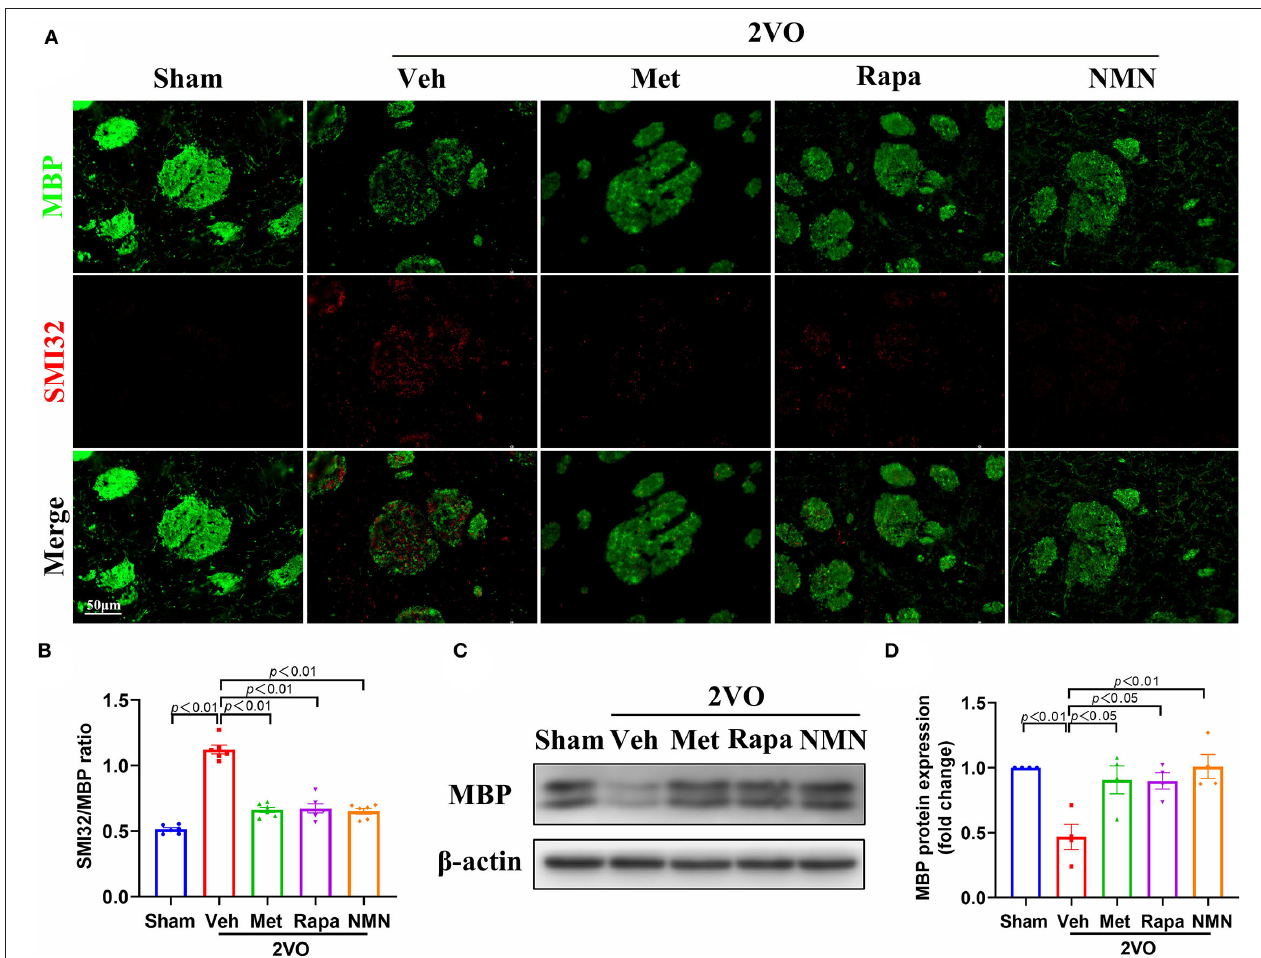
FIGURE 3 | Metformin, rapamycin, or NMN pretreatment improves axonal and oligodendrocyte damage induced after BCCAO. (A) Representative images of dephosphorylated neurofilament protein (SMI32, red) and MBP (green) in striatum 32 days after BCCAO in rats. (B) Quantification of the ratio of SMI32 to MBP fluorescence intensity in the striatum, illustrated as fold-change compared with the sham average value. n = 6 per group. The p -values were assessed by one-way ANOVA with a Tukey’s test. (C) Western blot analysis of MBP protein from the striatum in sham and BCCAO rats after treatment. (D) Quantitative analysis of MBP protein from the striatum in each group. MBP protein was normalized to the β -actin level of the same sample ( n = 4 per group). The p -values were assessed by one-way ANOVA with a Tukey’s test. All data were shown as mean ± SEM. Met, metformin; Rapa, rapamycin; NMN, nicotinamide mononucleotide; Veh, vehicle; 2VO, two-vessel